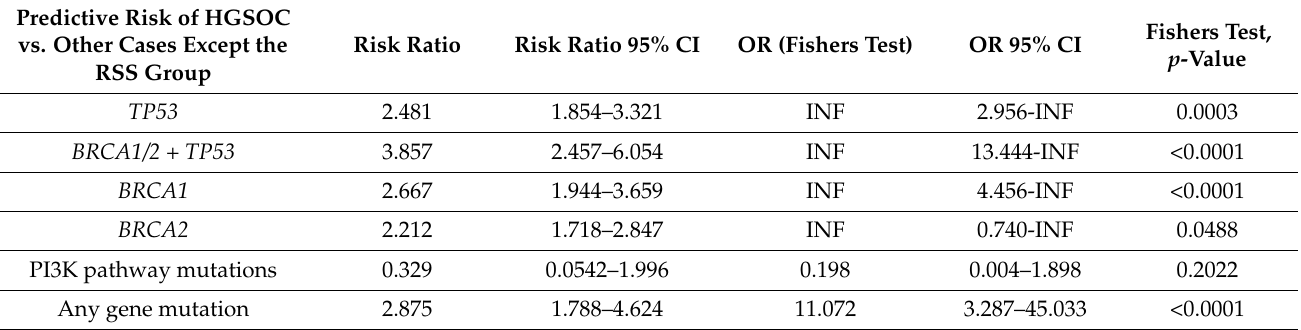
Table 4. Predictive value of uterine lavage mutations for type HGSOC diagnosis (comparing type II vs. controls, without the RRS group). OR—odds